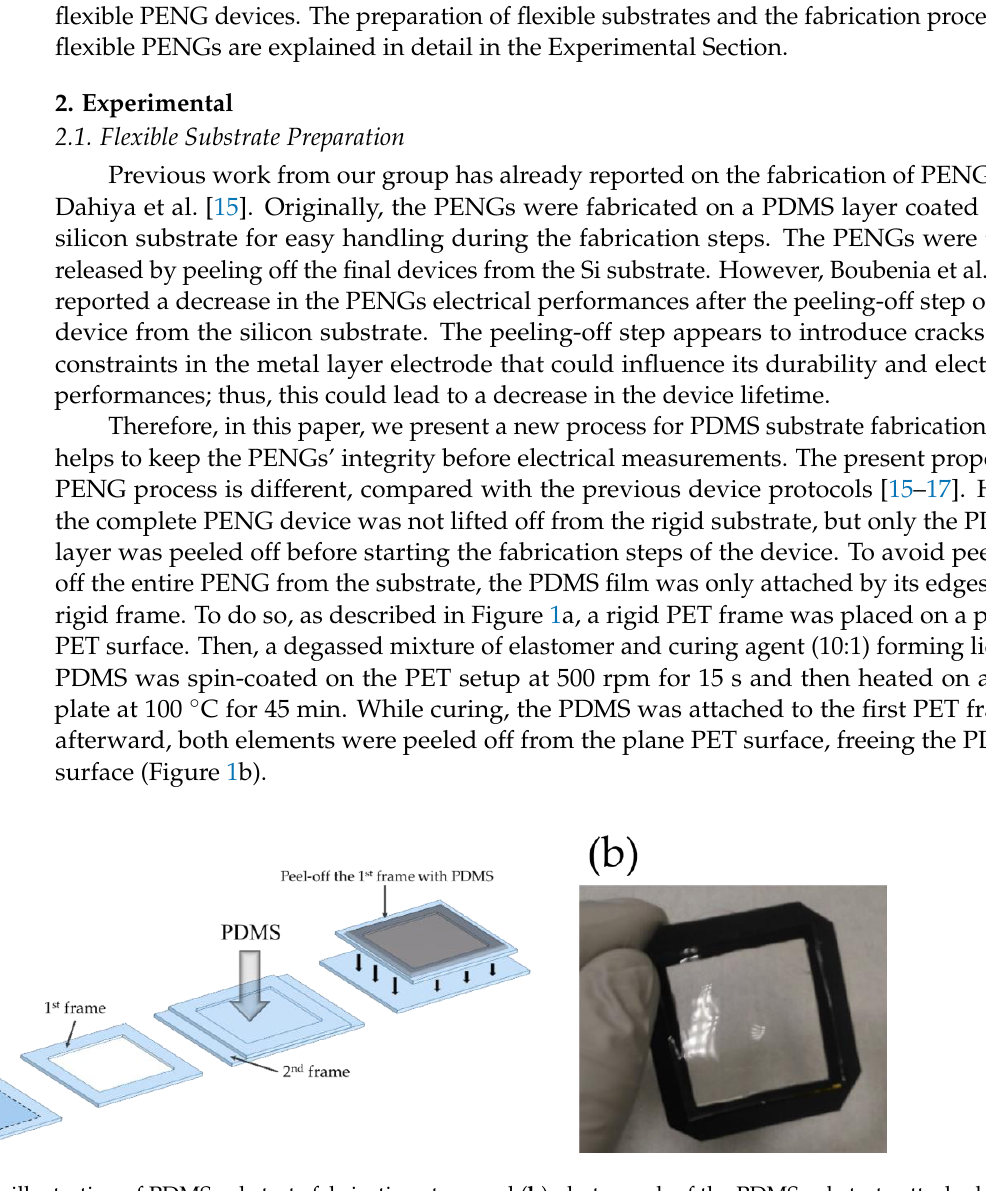
Figure 1. ( a ) Schematic illustration of PDMS substrate fabrication steps and ( b ) photograph of the PDMS substrate attached to the frame.